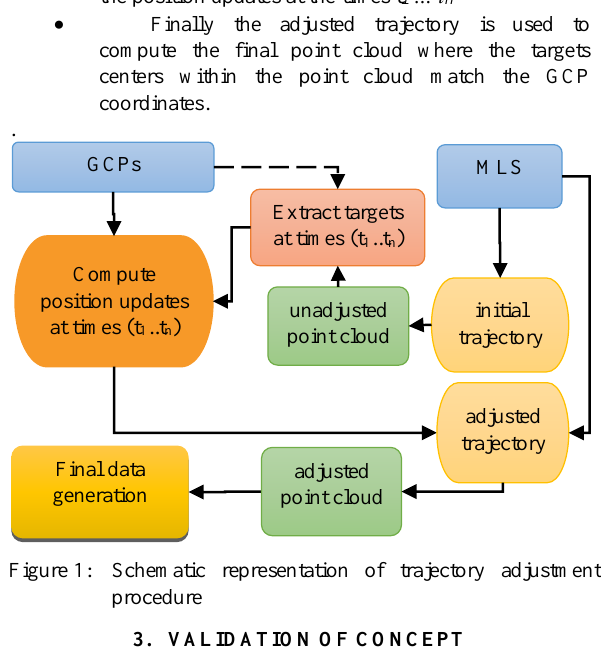
Figure 1: Schematic representation of trajectory